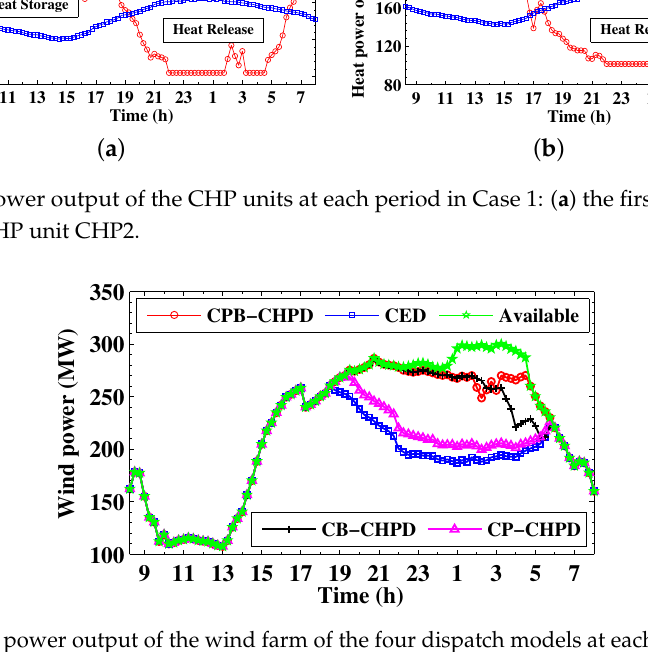
Figure 8. Electric power output of the wind farm of the four dispatch models at each period, including the CPB-CHPD, CB-CHPD, CP-CHPD models (combined heat and power dispatch models considering both PDTP and BTI, only BTI, only PDTP, respectively) and the CED model (conventional economic dispatch model considering neither PDTP, nor